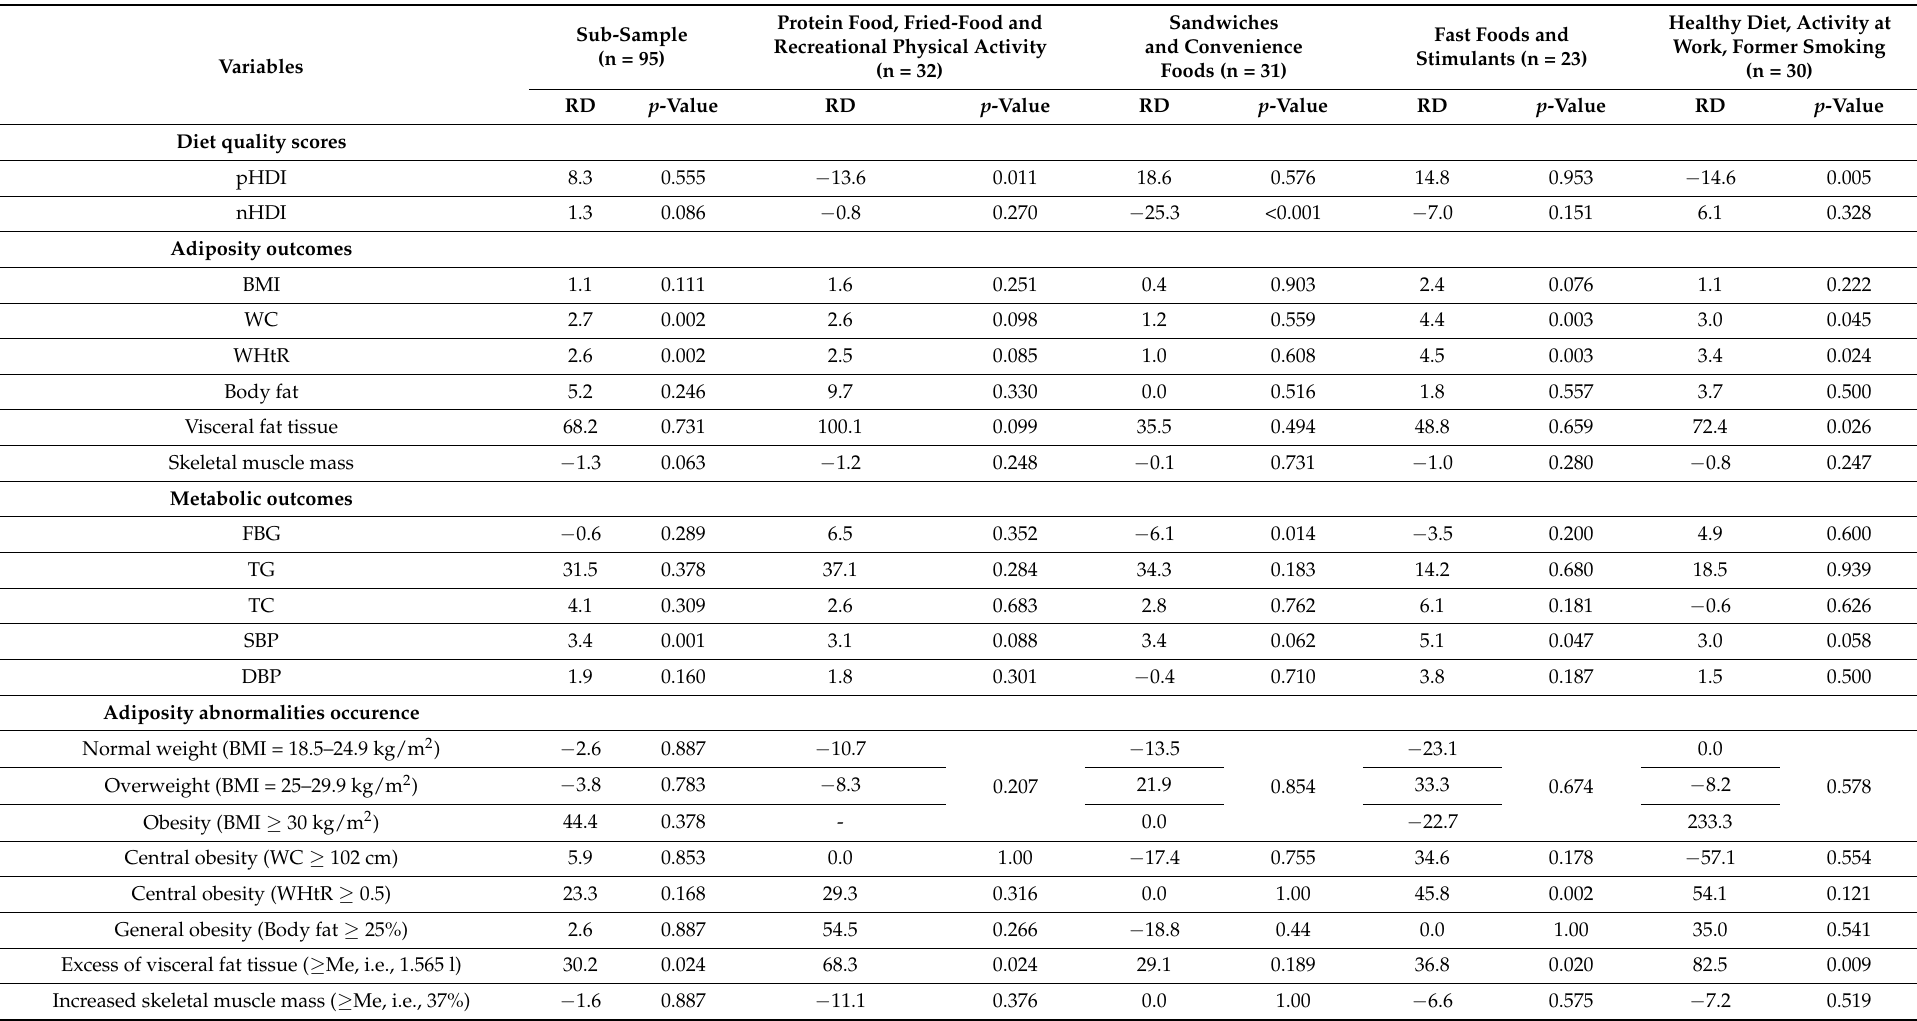
Table 3. Relative differences (RD, %) for means or % of the sample within sub-sample with higher adherence to each pattern in adiposity and metabolic outcomes by dietary lifestyle patterns # : before vs. 2 years